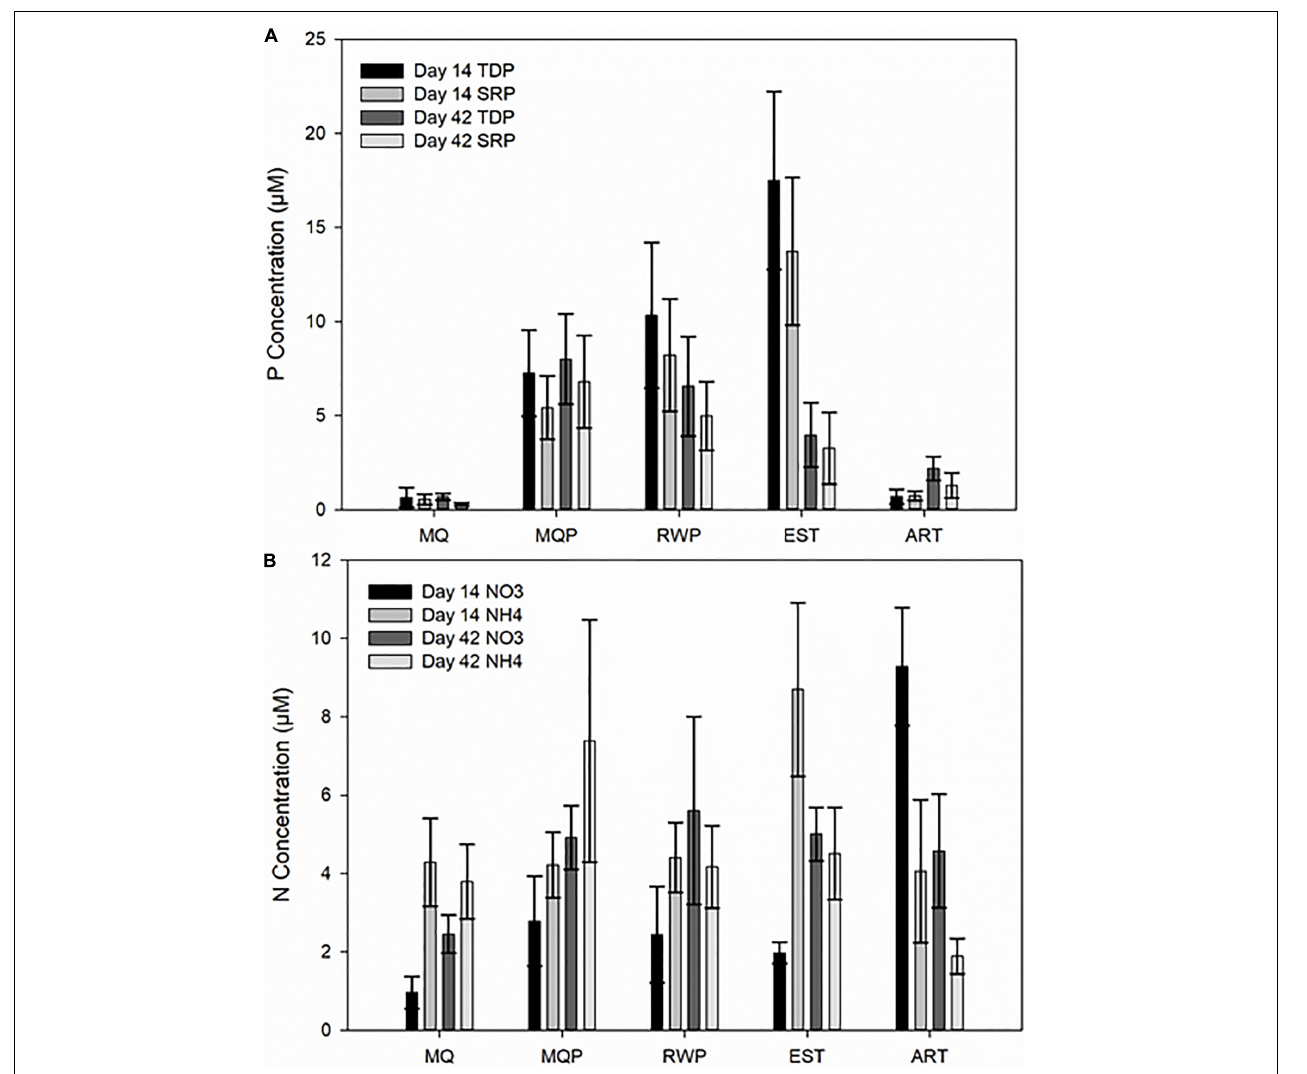
FIGURE 7 | Dissolved nutrient concentrations measured in pitcher fluid samples collected on day 14 and 42. (A) Total dissolved phosphorus (TDP), soluble molybdate-reactive P (SRP), and (B) nitrate (NO3) and ammonium (NH4) concentrations. Treatment abbreviations are the same as Figure 1